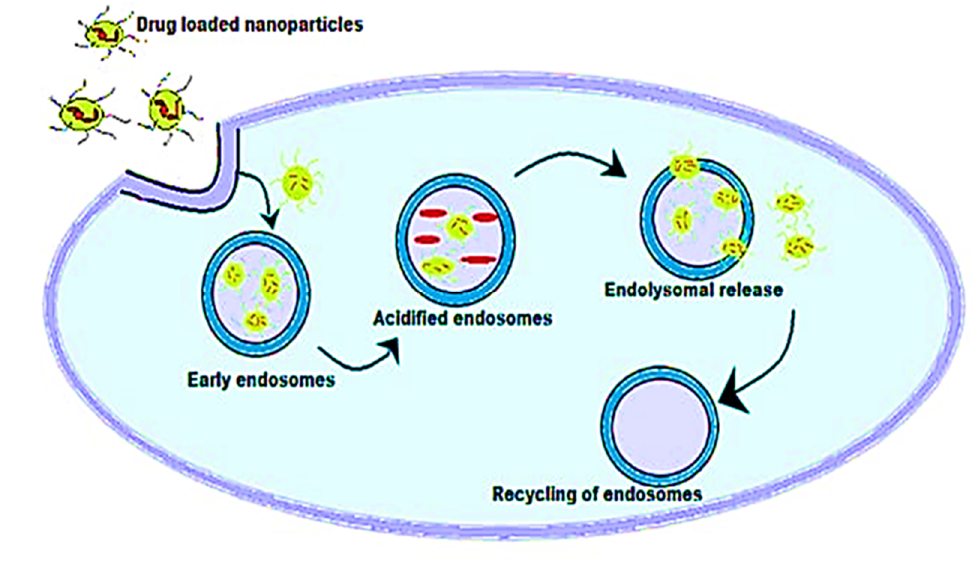
Figure 4. A schema of nanoparticle internalization in the cells.